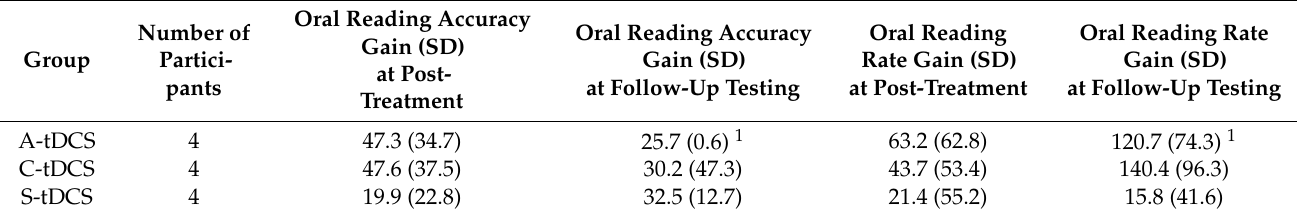
Table 5. Mean percent gains (Std Dev) in oral reading accuracy and rate by group at both post-treatment and six-week follow-up